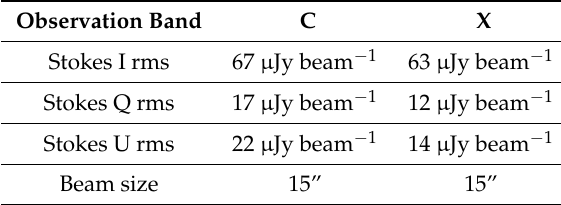
Table 2. Relevant data for galaxy